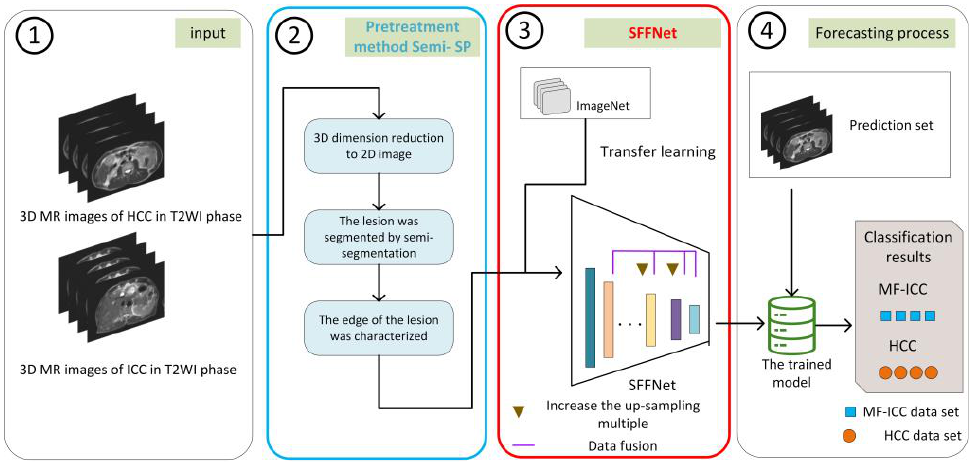
Figure 1. The pipeline of the proposed method